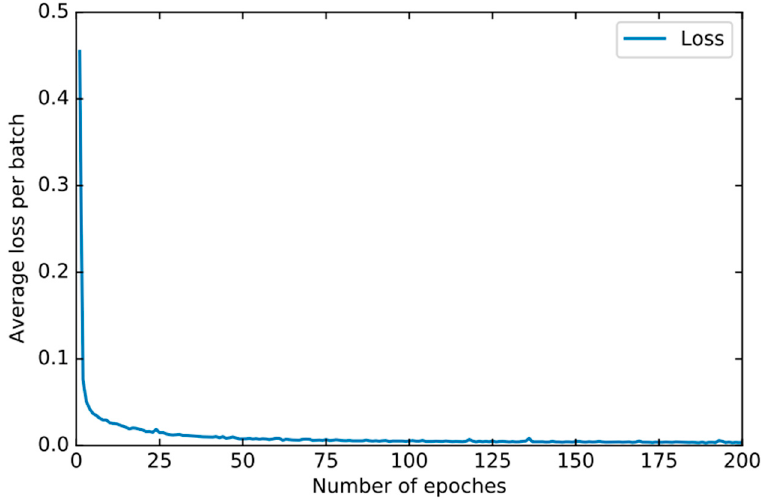
Figure 9. The training loss of DNN changes when different epochs are set.